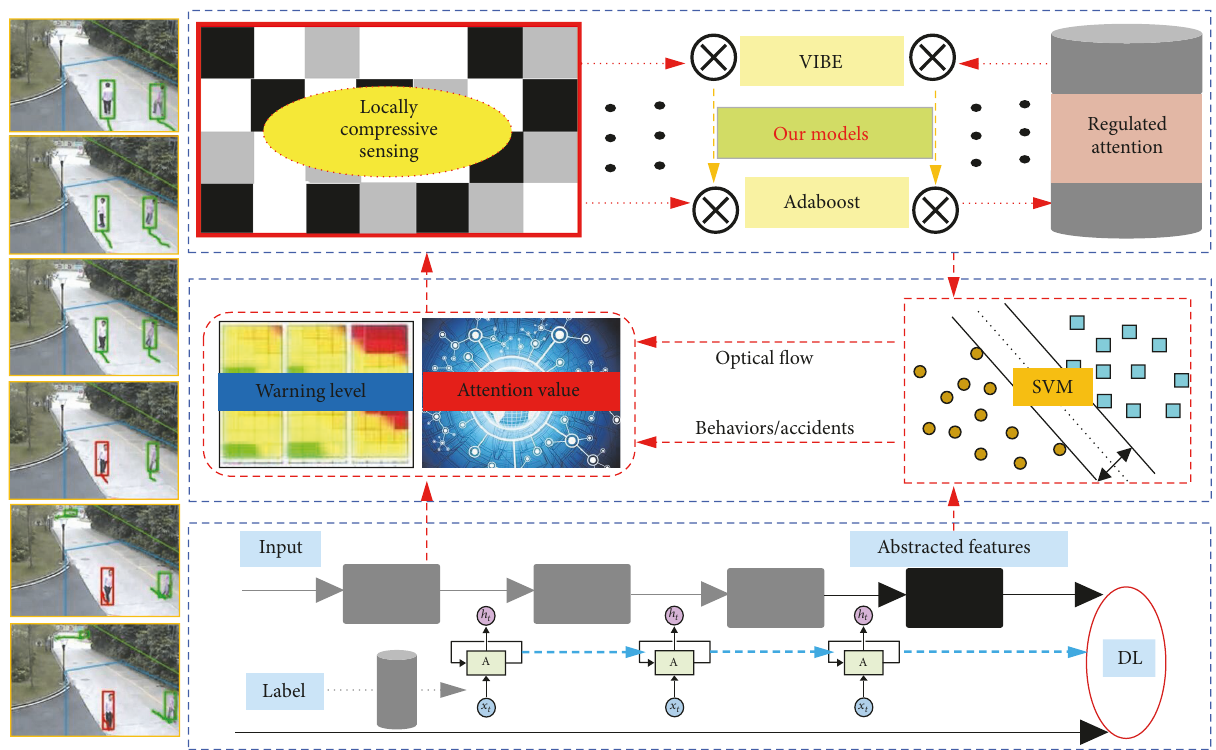
Figure 7: An example demands integration of proposed models with other online algorithms; smog as a global environmental change has significant implications to loitering detection within a hovering period of two persons, where only half warning of hovering behaviors is detected (highlighted by the red rectangles). A preliminary scheme for practical integration is subsequently